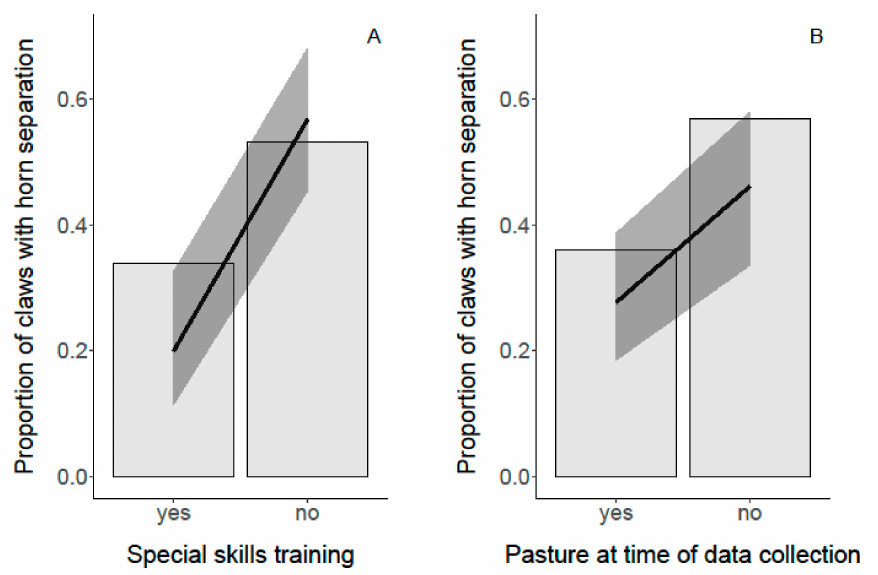
Figure 7. Association between “special skills training” ( A ) and “pasture at time of data collection” ( B ) and the proportion of claws with horn separation. The black lines represent the model estimates, the gray colored areas the 95% confidence